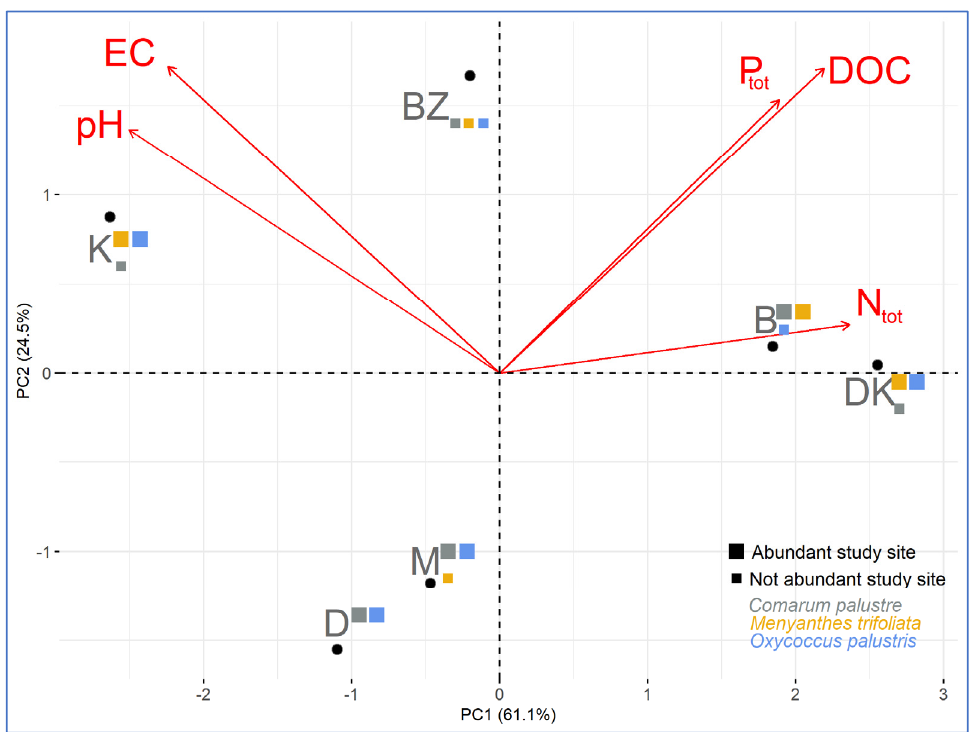
Figure 9. Principal component analysis (PCA) biplot for the physical-chemical variables at the study sites, taking into account the abundance of individuals of the studied species.